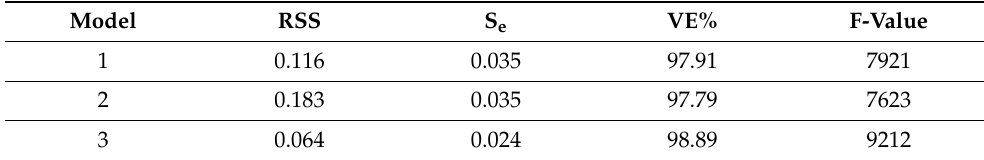
Table 2. Statistical parameters calculated by fitting the kinetic models to experimental results: residual sum of squares (RSS), standard error of estimate (S e ), percentage of variation explained (VE%), and Fisher’s value